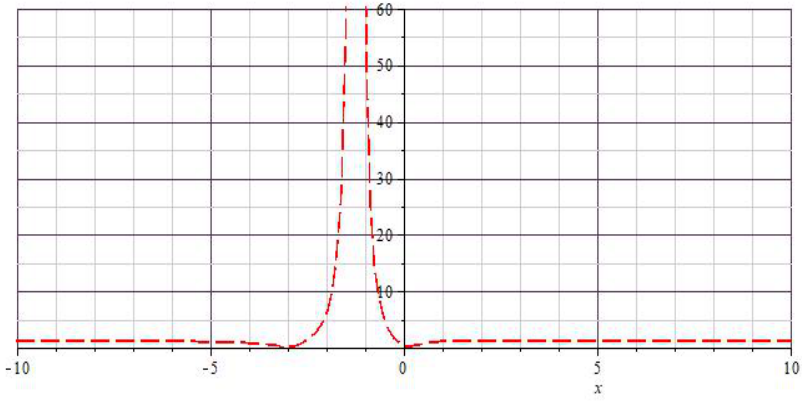
Figure 6. Graphical view of | Q 22 ( (cid:36) ) | for a 0 = 0.3, a 1 = 1.47, B = 0.69, u = 0.7, (cid:101) = 0.1, v = − 1.26, w = 0.2, A = 0.43: ( a ) 3D plot, ( b ) contour plot, and ( c ) 2D plot at t =